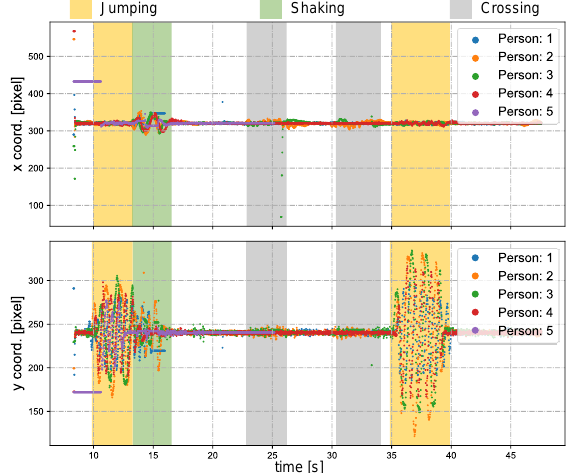
Figure 21. The x and y centroids of the regions with tracked